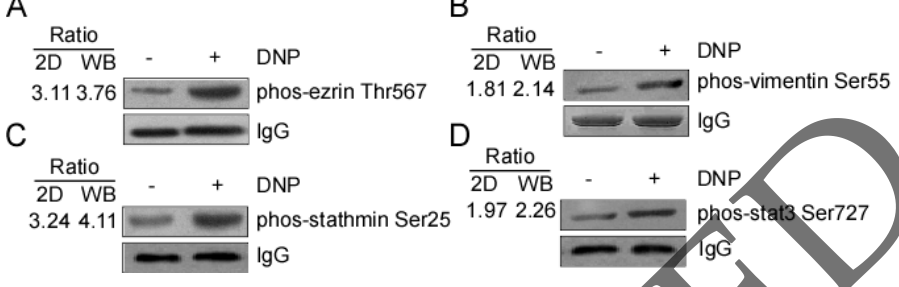
Figure 4. Validation of the representative phosphoproteins by Western-blotting. Representative proteins ezrin ( A ); vimentin ( B ); stathmin ( C ); STAT3 ( D ) of the immunoprecipitated proteins were detected by Western-blotting using anti-serine or threonine phosphorylation antibody. IgG served as the control. The relative Western-blotting ratio of phosphorylation levels of every protein was normalized to its corresponding proteomic data.